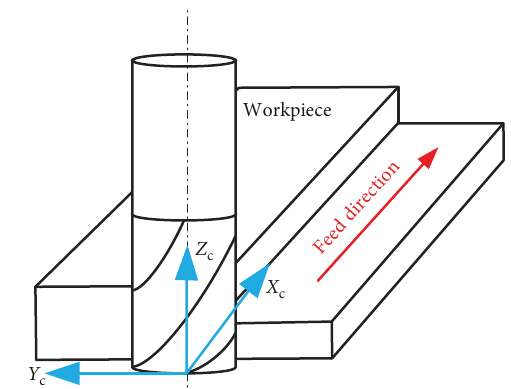
Figure 4: Cutter entering